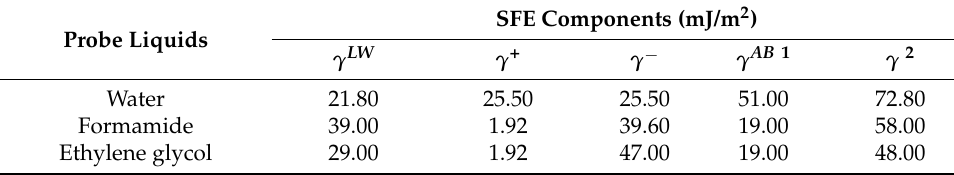
Table 2. SFE components of the probe liquids at 20 ◦ C.